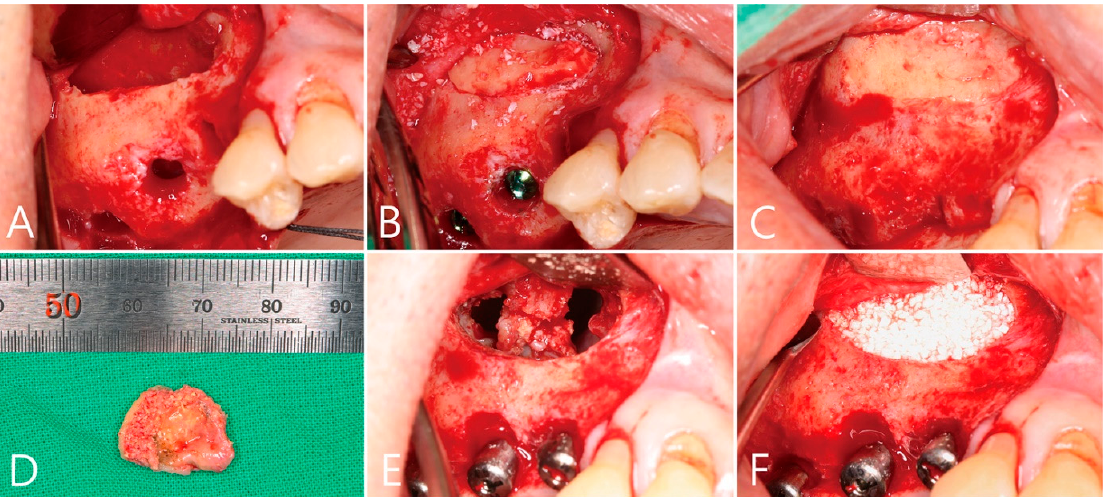
Figure 4. Case 2. ( A ) On preoperative panoramic radiography, severely atrophied residual ridges were observed in the missing area of the left and right maxillary molars, and the maxillary sinuses were pneumatized; ( B ) a panoramic image of the preoperative CBCT showed slight thickening of the sinus membrane on the sinus floor.